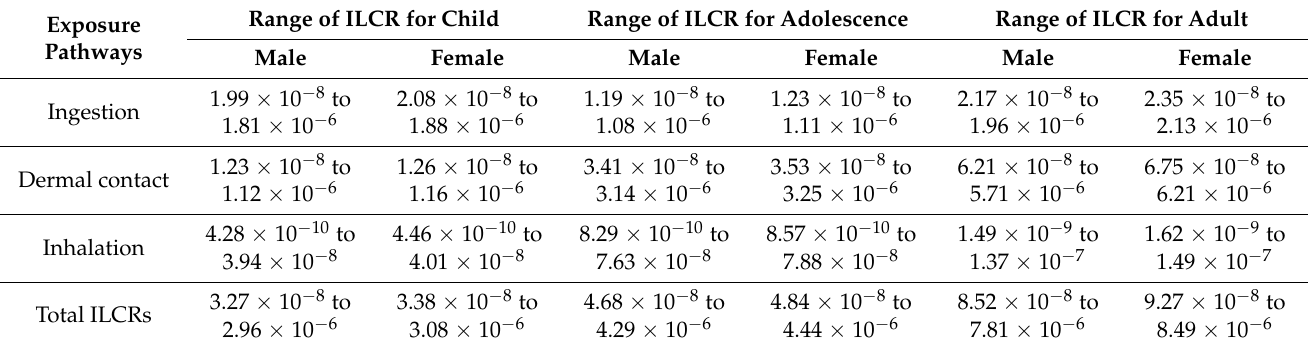
Table 6. Incremental lifetime cancer risks (ILCRs) for people via different exposure